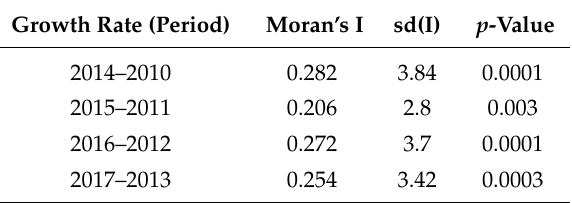
Table 2. Moran’s coefficient for GDP per